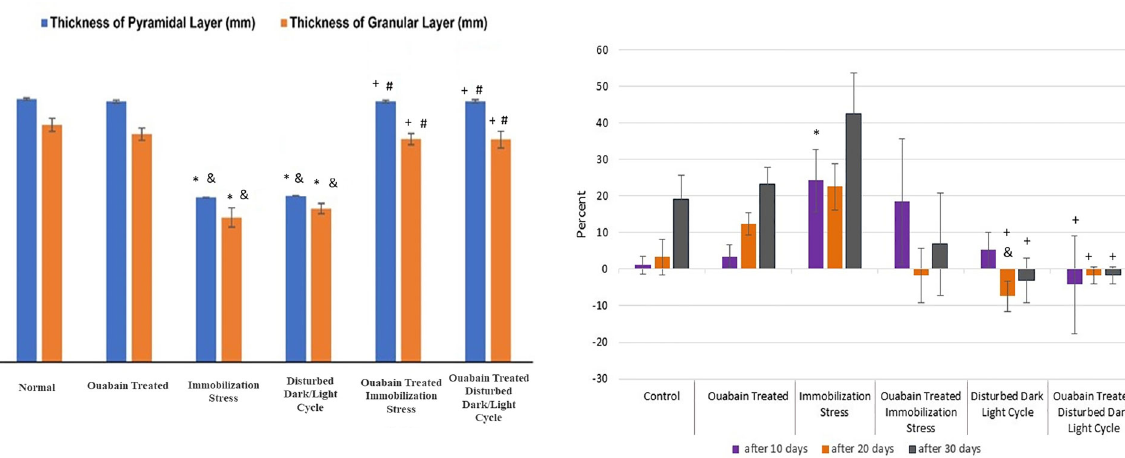
Figure 10. Percent changes in body weight after 10, 20, and 30 days in the study groups. Data are reported as means ± SD. *P o 0.05 compared to control group. & P o 0.05 compared to OUA-treated group. + P o 0.05 compared to untreated immobi- lized rats (Kruskal-Wallis